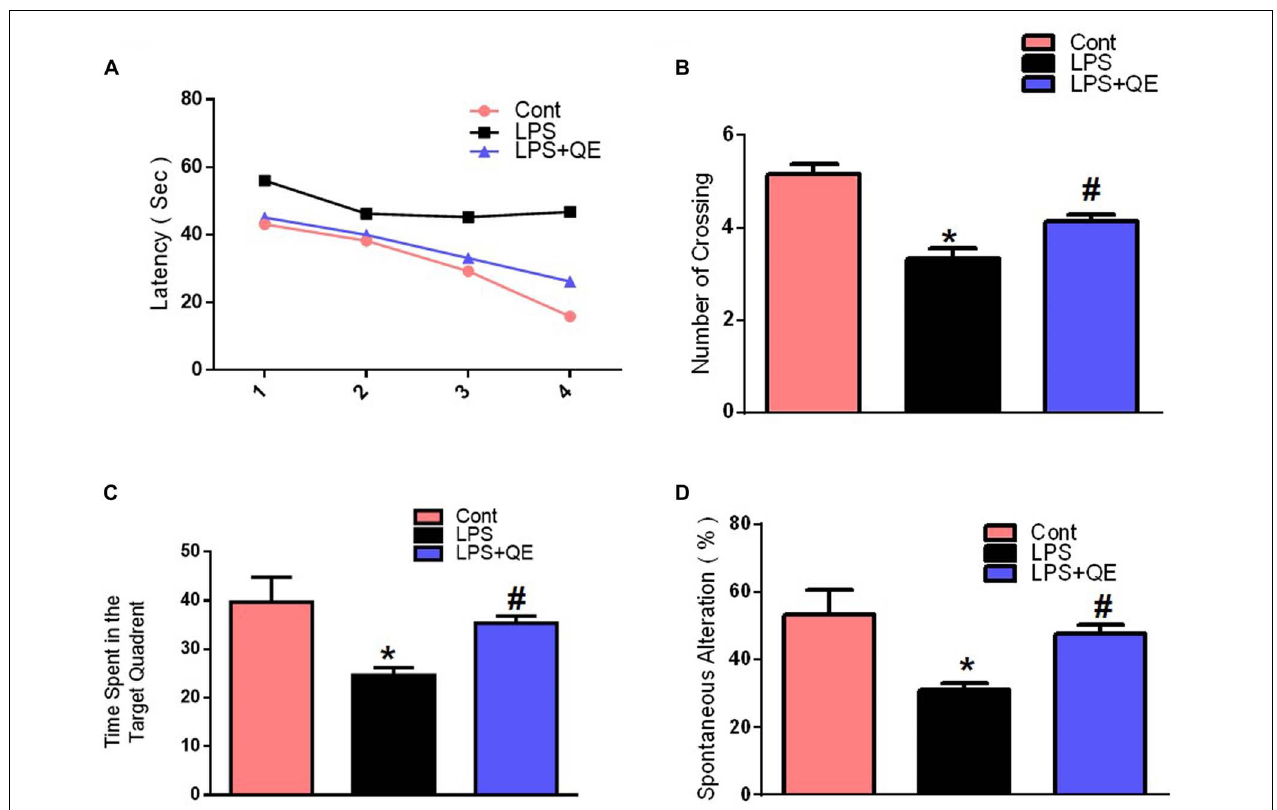
FIGURE 2 | Quercetin improved the memory function of the LPS-treated mice. For the behavioral analyses, the MWM and Y-maze tests were used to investigate and evaluate the memory functions of the control, LPS and LPS+quercetin group mice. (A) Average escape latency time for experimental mice to reach the hidden platform from 1 to 4 days. (B) The average number of crossings at the hidden platform during the probe test of the MWM test. (C) Time spent in the platform quadrant, where the hidden platform was placed during the trial session. (D) Spontaneous alteration behavior % of the mice during the Y-maze test. Histograms indicate the means ± SEM for the mice ( n = 15/group). ∗ Significantly different from the control; # significantly different from LPS-treated group. Significance: P <